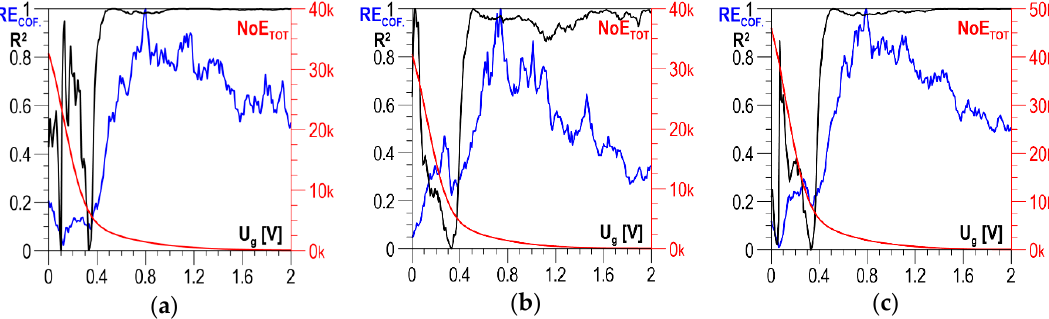
Figure 14. Averaged NoE TOT distributions and distributions of coefficients RE COF. and R 2 as a function of threshold voltage U g —Configuration C1 ( a ) parallel direction; ( b ) normal direction; ( c ) absolute value.